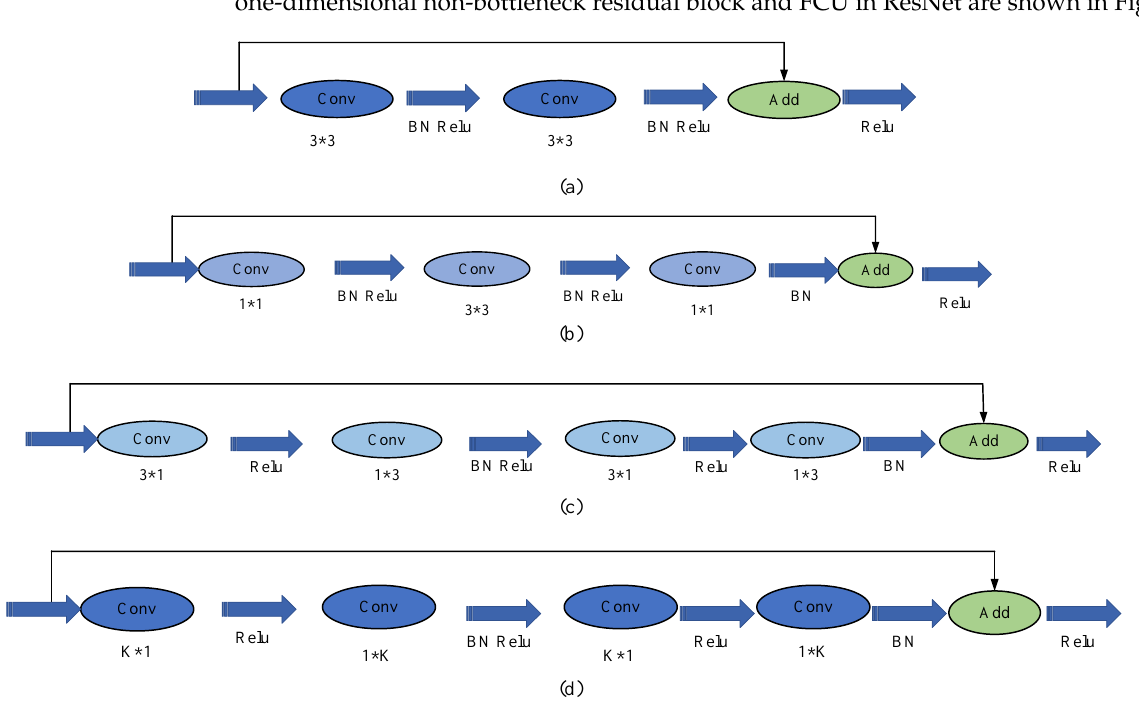
Figure 9. Structure diagram of the residual module of the PFCU: ( a ) non-bottleneck residual block; ( b ) bottleneck residual block; ( c ) one-dimensional non-bottleneck residual block; ( d ) FCU. The size of the convolutional layer in the main branch structure of the bottleneck residual block is 1 × 1, 3 × 3, and 1 × 1. The function of two convolutional structures is to increase or decrease the channel dimension, and an activation function is added between the convolutional layers to realize batch processing of the normalization layer. pixel by pixel.